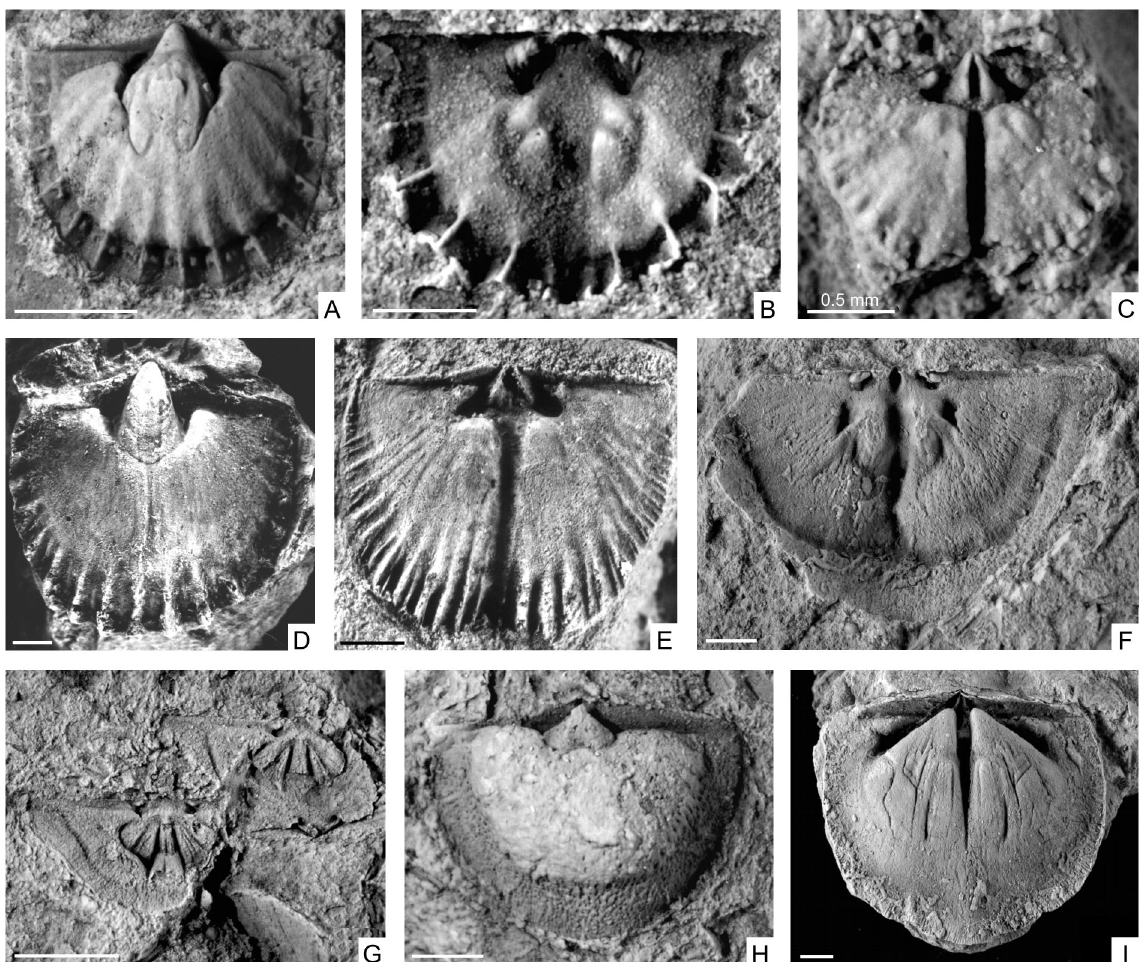
Fig. 1. Representative brachiopods of the Saucrorthis Fauna. A , B , Saucrorthis minor , A, NIGP136194, ventral internal mould; B, NIGP136369, dorsal internal mould. C , Protoskenidioides weixinensis , NIGP139097, dorsal internal mould. D , Orthambonites delicata , NIGP134299, ventral internal mould. E , Parisorthis dischidanteris , NIGP134347, dorsal internal mould. F , Leptellina spatiosa , NIGP139117, dorsal internal mould. G , Calyptolepta huanghuaensis , NIGP139142, dorsal internal